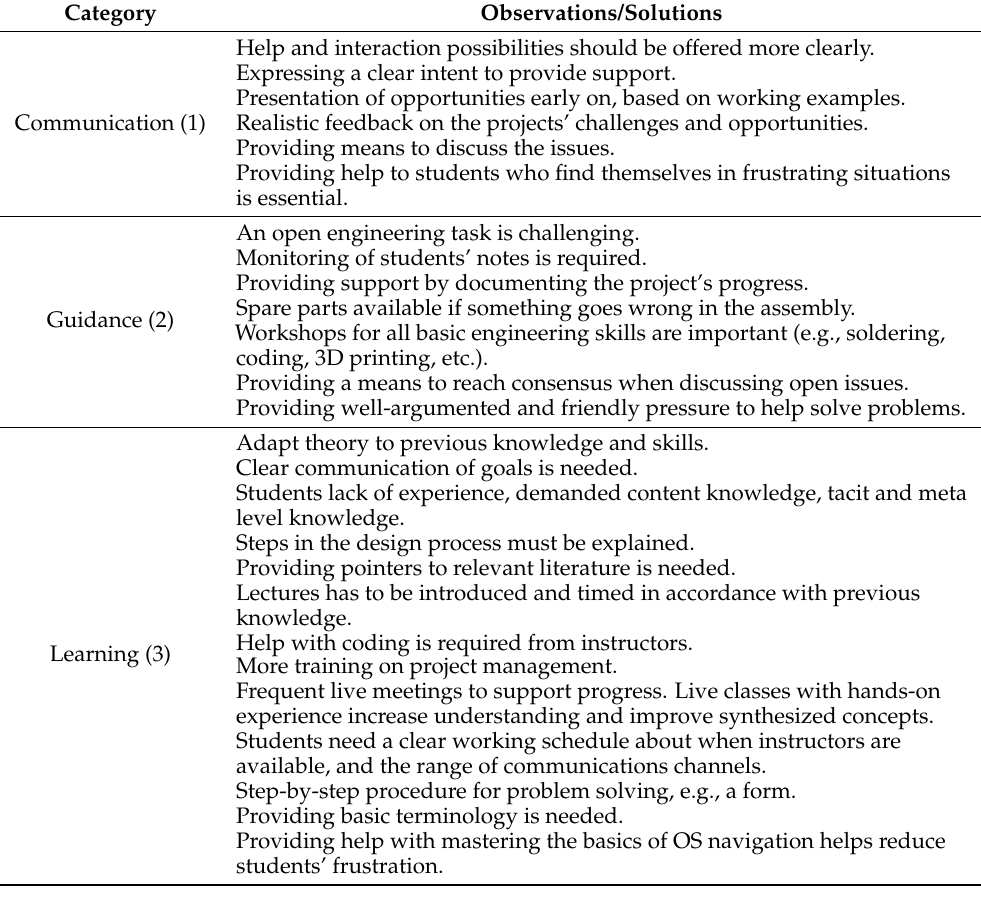
Table 3. Categorized observations associated with the challenges that the engineering approach initiates (RQ2).